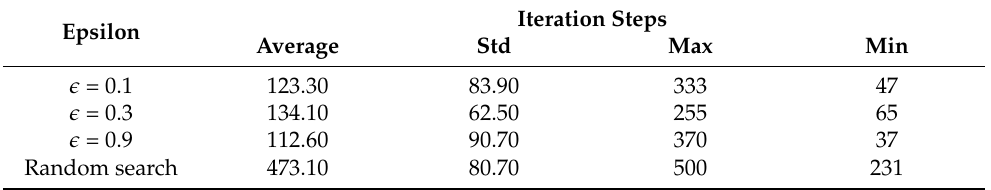
Table 3. Comparison of iteration steps to convergence for varying epsilon values and random search.